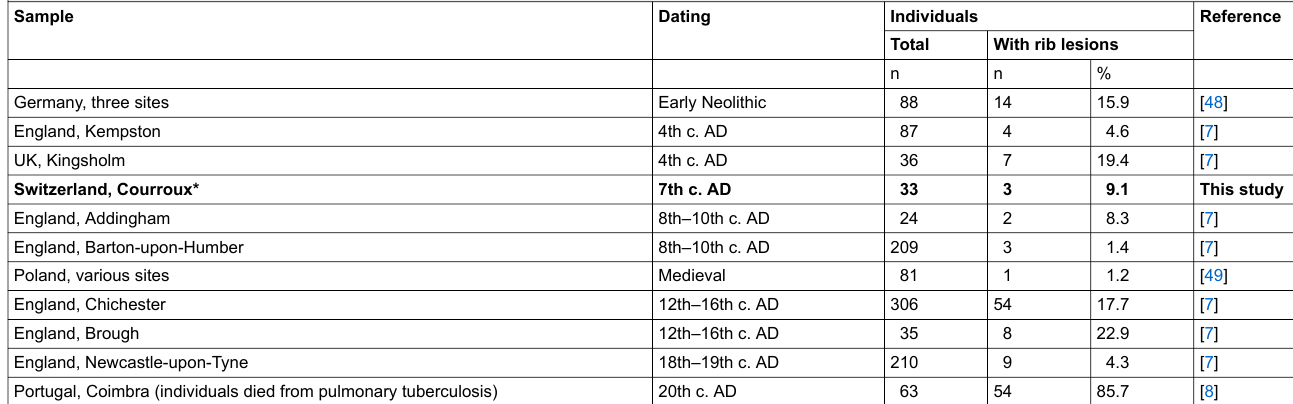
Table 3: Number and percentage of individuals affected by rib lesions in different European sites. IndividualsSample